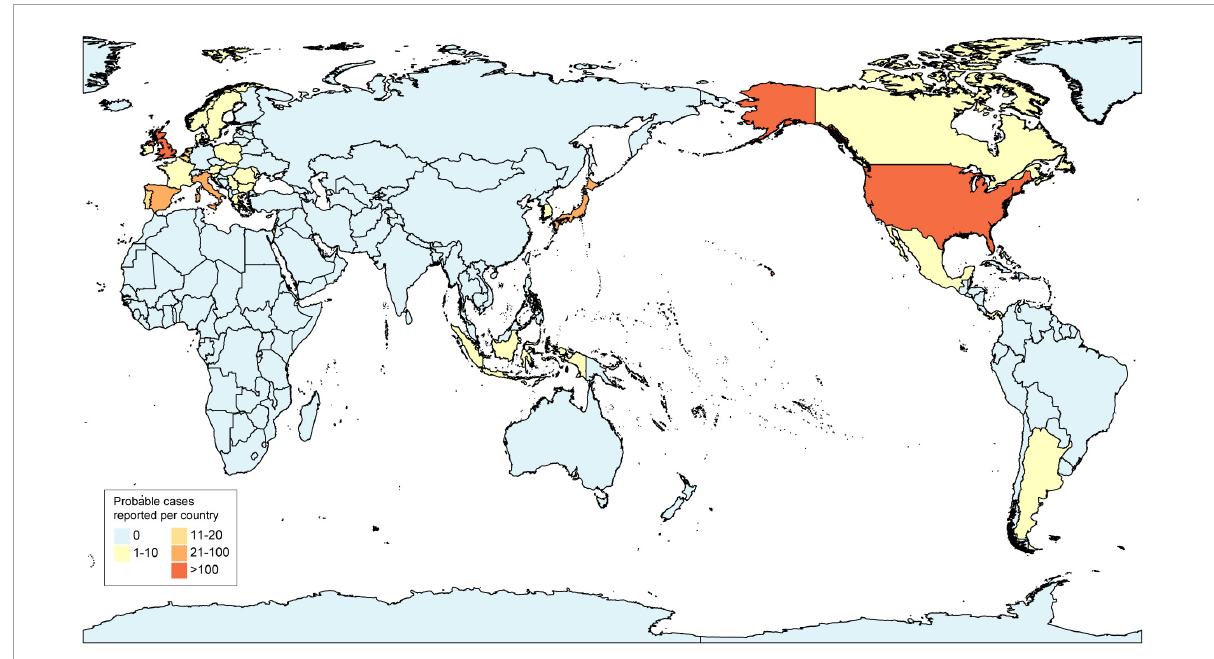
FIGURE1 Distribution of probable cases of acute hepatitis of unknown etiology by country, as of 26 May